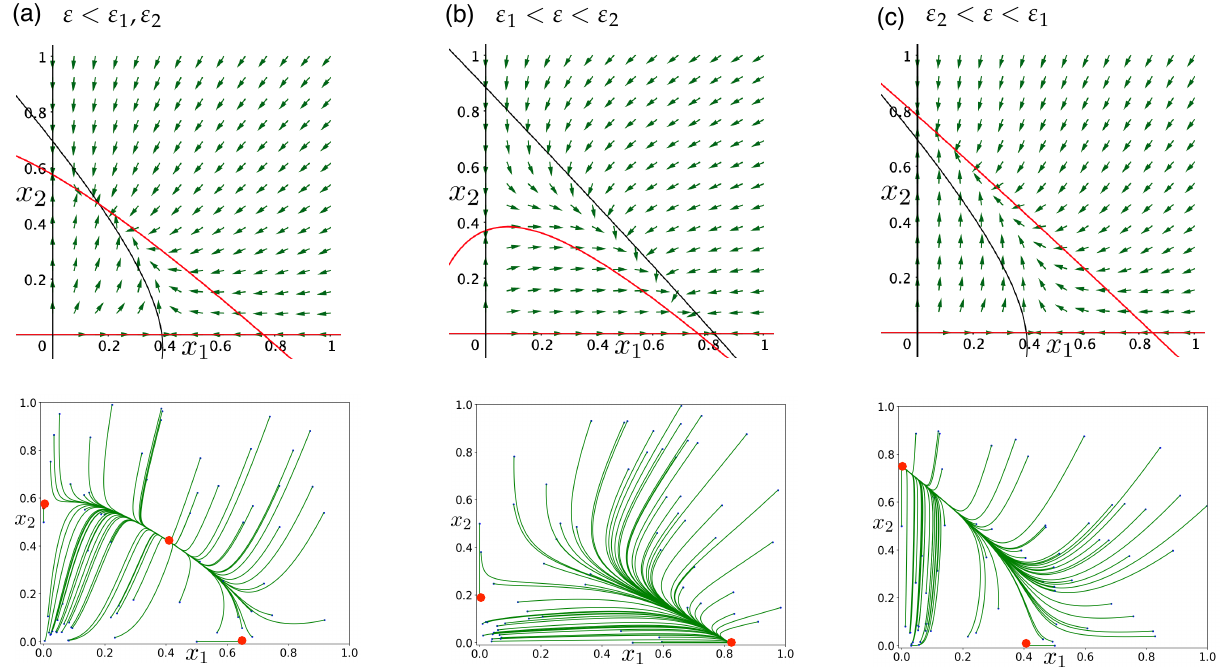
Figure 9. All possible phase portraits for the two-member hypercycle with exponential replication Figure 3. The direction of the dynamical system vector field for all possible situations regarding ε < α 1 , α 2 / η ε together with Figure 8. Direction of the dynamical system vector field for all possible situations regarding # < Figure 8. Direction of the dynamical system vector field for all possible situations regarding # < parameter higher than its decay rate in both species. In particular, the plots have been obtained for nullclines g ( x 2 ) and h ( x 1 ) plotted in black and red, respectively. Parameters used: ( a ) ε = 0.16, k = 0.74, α 1 = 0.28, α 2 = 0.4; a 1 , a 2 / h # together with isoclines g ( x 2 ) and h ( x 1 ) plotted in black and red, respectively. Parameters a 1 , a 2 / h # together with isoclines g ( x 2 ) and h ( x 1 ) plotted in black and red, respectively. Parameters the values: (a) a 1 = 0.39, a 2 = 0.94, # = 0.14, k = 1, h k = 3.6, h # = 2.95; (b) a 1 = 0.77, a 2 = 0.51, # = ( b ) ε = 0.17, k = 0.59, α 1 = 0.96, α 2 = 0.27; ( c ) ε = 0.17, k = 0.40, α 1 = 0.28, α 2 = 0.78. Below, we display all possible phase used: (a) # = 0.16, k = 0.74, a 1 = 0.28, a 2 = 0.4; (b) # = 0.17, k = 0.59, a 1 = 0.96, a 2 = 0.27; (c) # < # 1 , # 2 . 0.14, k = 0.28, h k = 3.6, h # = 2.95; (c) a 1 = 0.27, a 2 = 0.93, # = 0.16, k = 0.3, h k = 0.35, h # = 1.45. portraits for the two-member hypercycle with exponential replication parameter higher than its decay rate in both species. In particular, the plots have been obtained for the values: ( a ) α 1 = 0.39, α 2 = 0.94, ε = 0.14, k = 1, η k = 3.6, η ε = 2.95; ( b ) α 1 = 0.77, α 2 = 0.51, ε = 0.14, k = 0.28, η k = 3.6, η ε = 2.95; ( c ) α 1 = 0.27, α 2 = 0.93, ε = 0.16, k = 0.3, η k = 0.35, η ε = 1.45. Stable equilibria are denoted with red solid